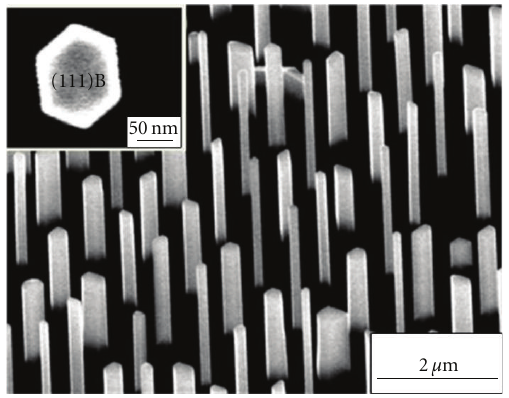
Figure 12: SEM images of GaAsP NWs grown at 750 ◦ C with V/III ratio of 20. Upper left inset is SEM image of top view of NW [33].